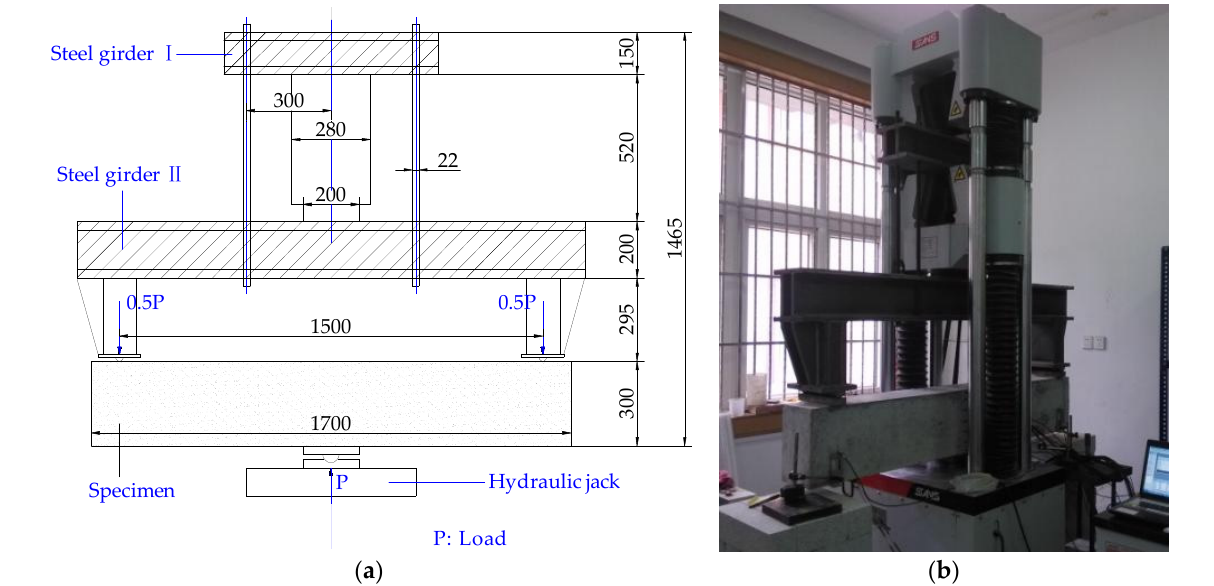
Figure 2. Test loading device: ( a ) schematic diagram of the test setup; ( b ) overview of the test setup (mm).